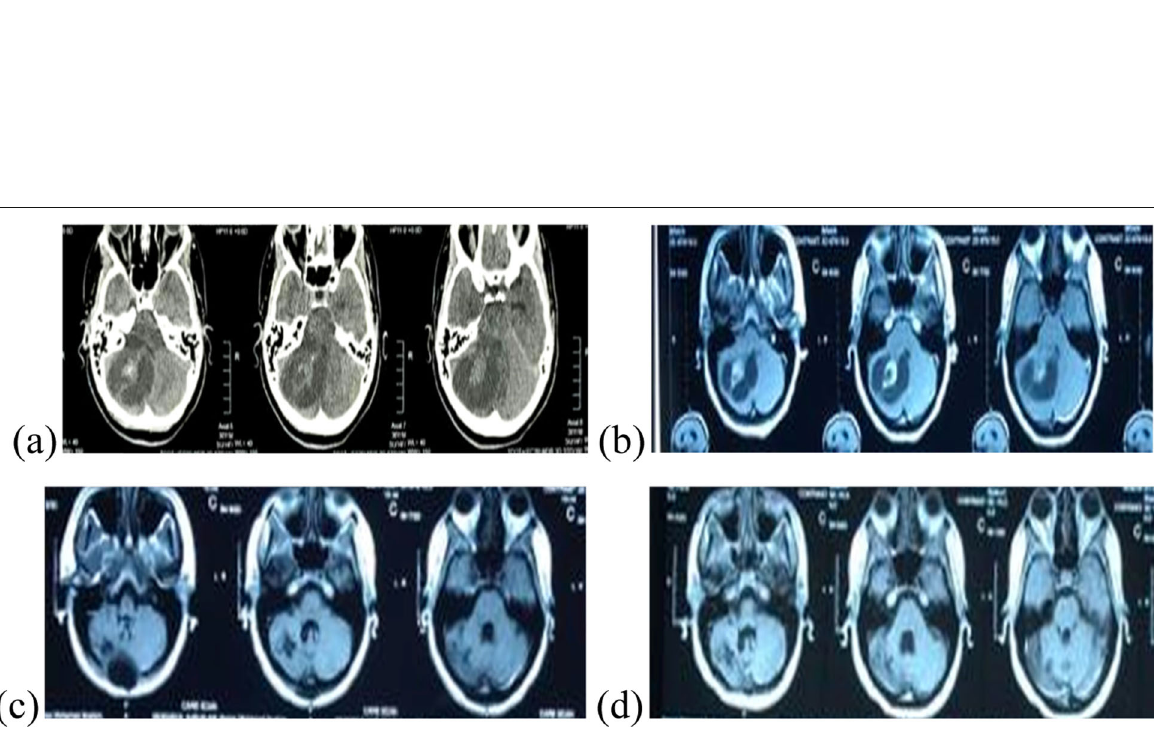
Fig. 4 a – d Female patient 30 years old of ganglioglioma. a Preoperative CT brain. b Preoperative T1-weighted MRI brain axial views with gadolinium. c , d Postoperative T1-weighted MRI axial views with gadolinium after 3 and 6 months